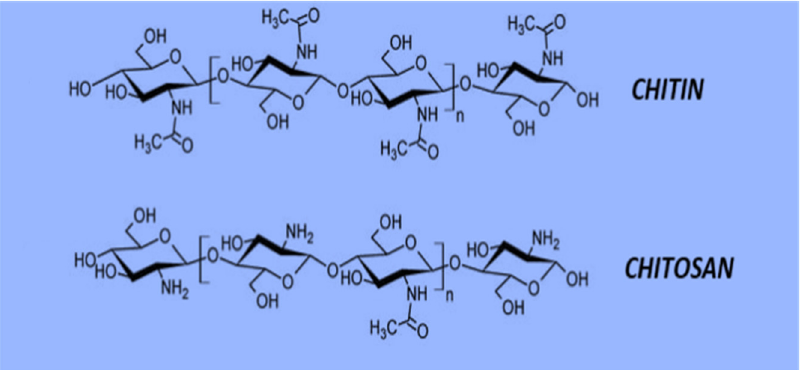
Figure 2. Structural analysis of chitin and chitosan. Reproduced with permission from [53].